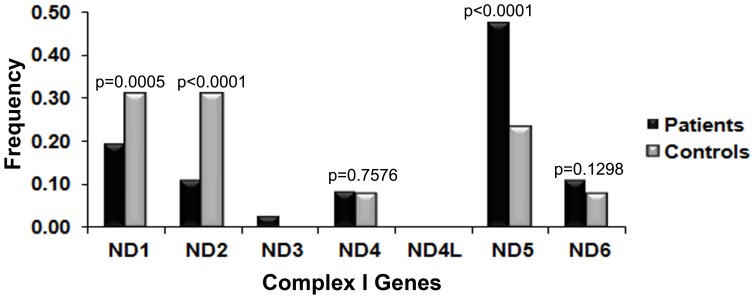
Distribution of non-synonymous unique segregating sites (USS) in Complex I genes.The frequency of non-synonymous USS was significantly higher (p<0.0001) in patients compared to controls in the case of the ND5 gene. However, the frequency of USS was higher for controls in ND1 and ND2.